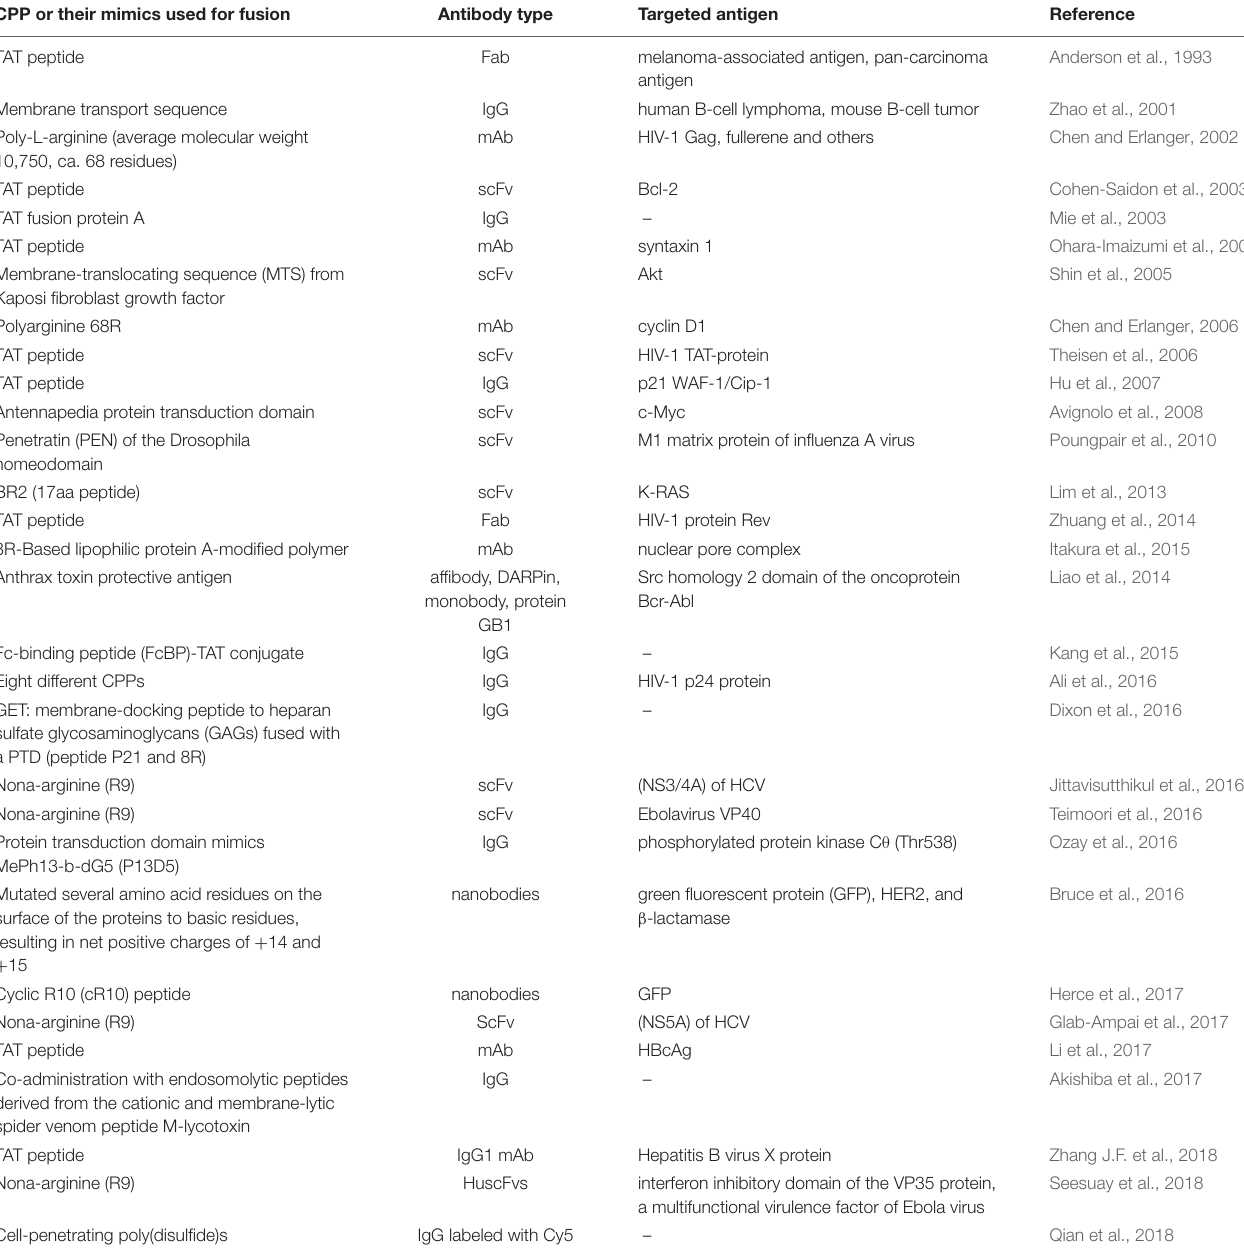
TABLE 2 | Examples of intracellular delivery of CPP-fused